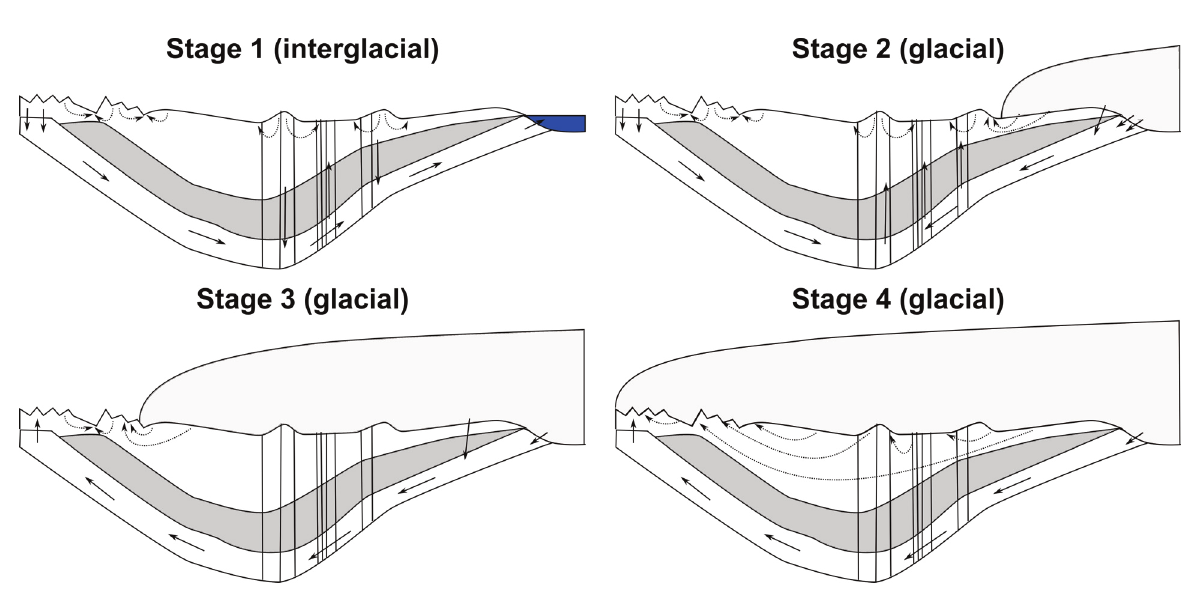
Fig. 2. Presumed flow patterns in interglacial and glacial periods, controlled by the expansion and retreat of the ice sheet. In the shallow aquifers (dashed arrows) and the Liepaja–Pskov fault zone, flow is mainly driven by topography during interglacial periods (Stage 1). During glacial periods (Stages 2–4), it is assumed that the fault zone has negligible influence on water flows and flow is mainly driven by ice sheet topography (Gerber et al. 2017). From Gerber et al. (2017).